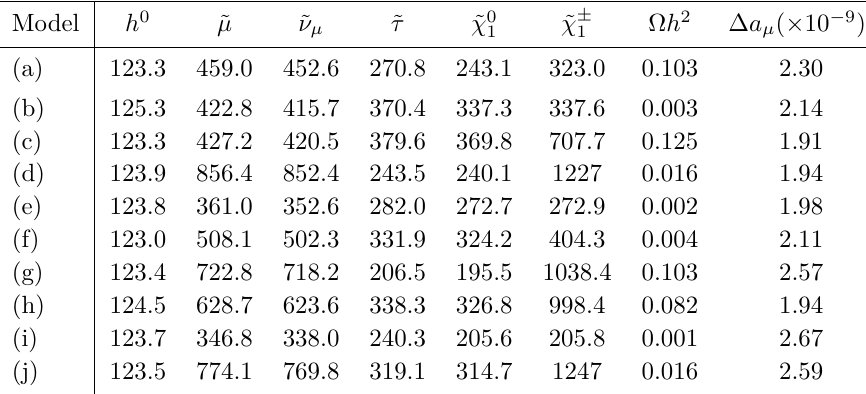
Table 7 . Low scale SUSY mass spectrum showing the Higgs boson, the smuon, the muon sneutrino, the stau and the light electroweakino masses and the LSP relic density for the benchmarks of table 6. Also shown is ∆ a µ .